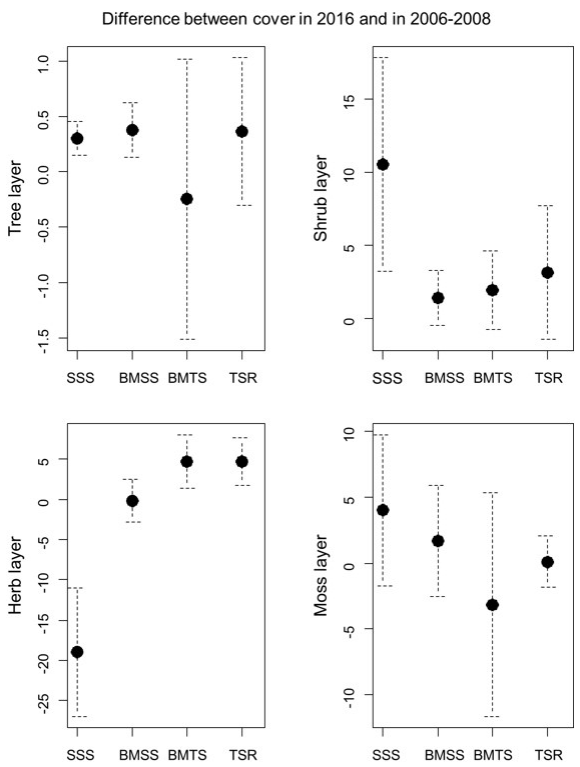
Figure 7. Means and 95 % confidence intervals for the differences in cover of tree, shrub, herb and moss layers between 2016 and 2006–2008, expressed in percentage points, in four open fen vegetation types: (SSS) Sphagnum - small sedge fen (Type 2), (BMSS) brown moss - small sedge fen (Type 1), (BMTS) brown moss - tall sedge fen (Type 3), (TSR) tall sedge -reed fen (Type 4); analysed jointly for Transects I, II, IIb, III and IV.